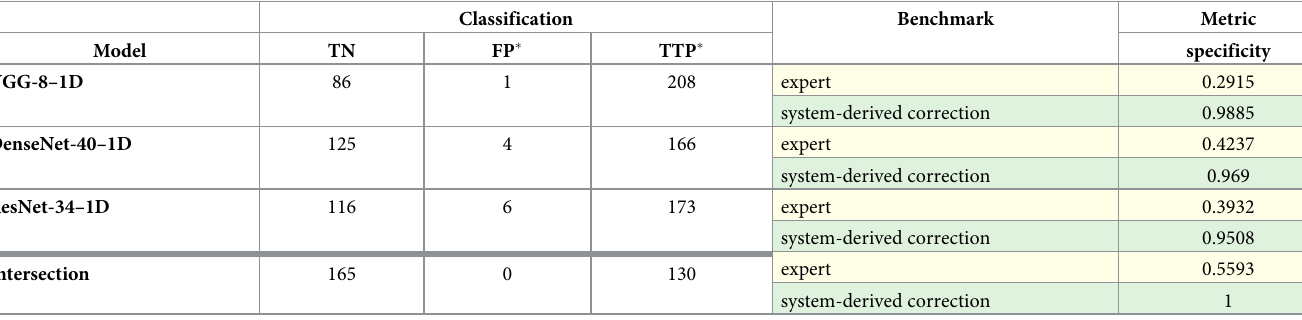
Table 4. Evaluation (2) of the results of stage 2 analysis of testing GC-MS